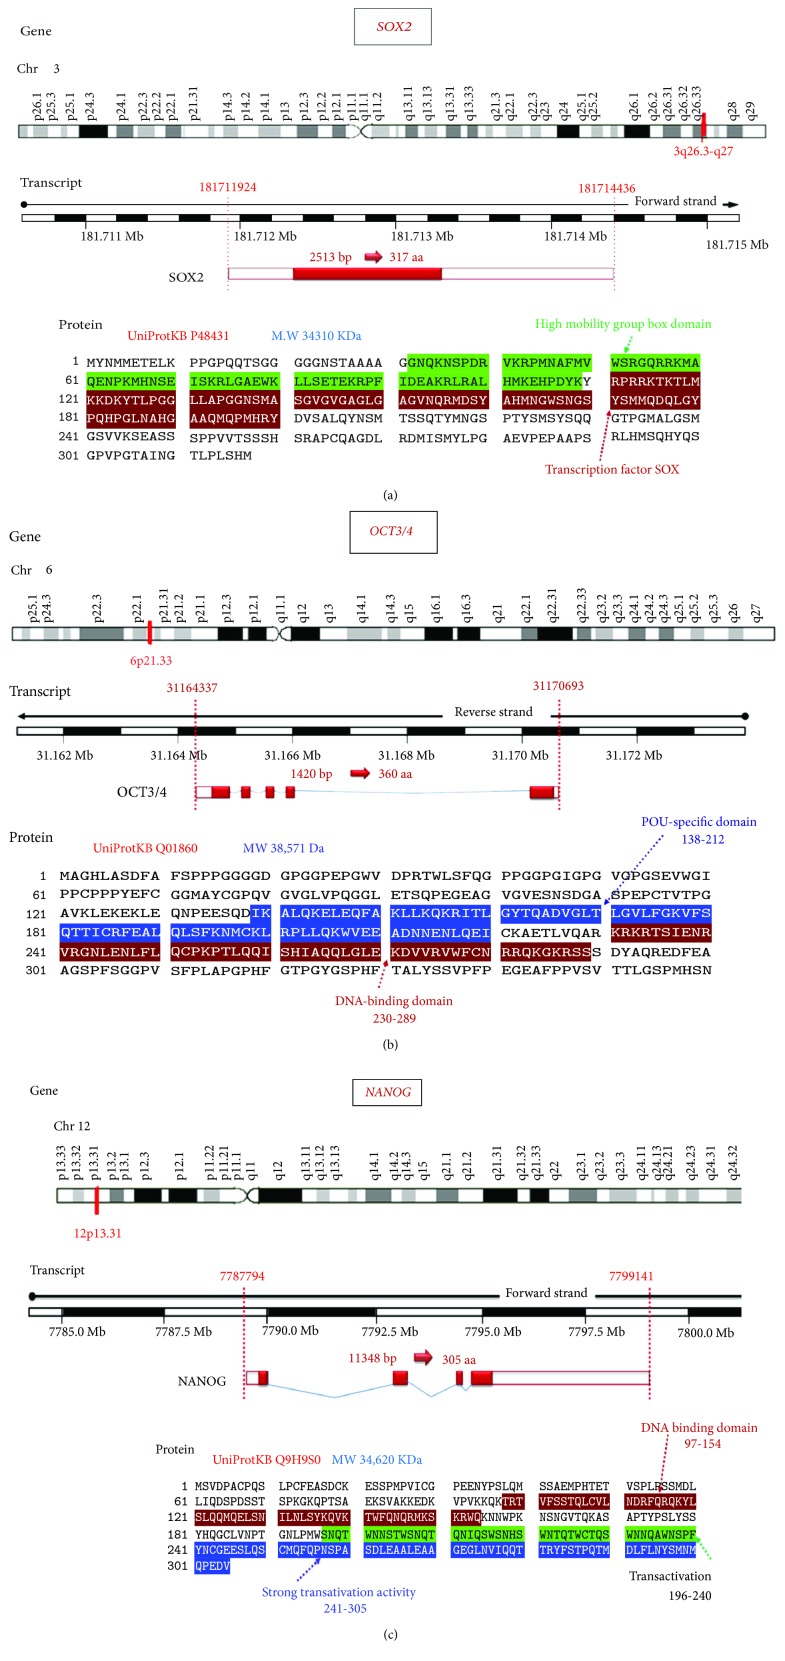
Structural analysis of the studied longevity-related genes. (a) SOX2 gene (OMIM 184429) location in chromosome 3q26.33. The complete gene spans 2513 bases of genomic DNA (NC_000003.12; Chr 3: 181,711,924 to 181,714,436, plus strand; human genome assembly GRCh38). This intronless gene encodes a member of the SRY-related HMG-box family of transcription factors (translation length: 317 amino acids). SOX2 refers to the primary and predominant transcript of the SOX2 gene. The high-mobility group box domain amino acid sequence in the SOX2 transcription factor is highlighted by green color and the DNA-binding domain sequences are brown colored. (b) NANOG gene (OMIM: 607937) location in chromosome 12p13.31. The complete gene spans 11,348 bases of genomic DNA (NC_000012.12; Chr 12: 7,787,794 to 7,799,141, plus strand). The encoded protein (305 amino acids). (c) OCT3/4 gene (OMIM: 164177) location in chromosome 6p21.33. The gene spans 1420 bases of genomic DNA (NC_00006.12; genomic coordinates (GRCh38): 6: 31,164,337-31,170,693, minus strand). The gene encodes a transcription factor (360 amino acids) containing a POU-specific homeodomain (blue amino acid sequences) and DNA-binding domain (brown amino acid sequences). MW: molecular weight; Da: Dalton; aa: amino acids (data source: http://Genecards.org, http://Ensembl.org and UniProtKB).